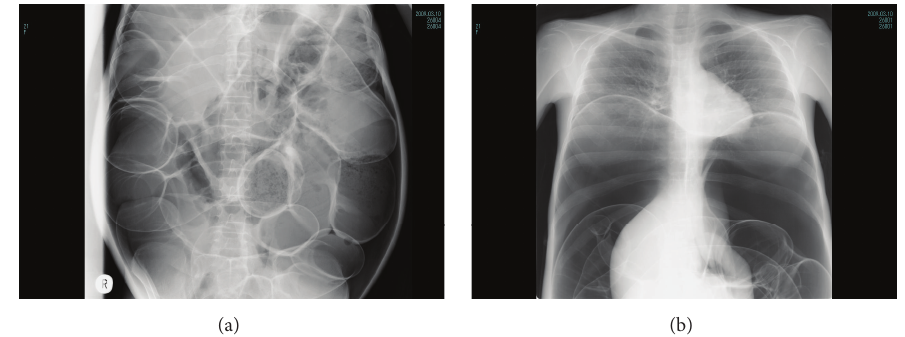
Figure 1: Plain radiographs ((a) lateral view of the abdomen and (b) frontal view of the chest and abdomen) show extensive gas in the colon wall, a dominance of air in the abdominal cavity above the colon, and secondary diaphragmatic